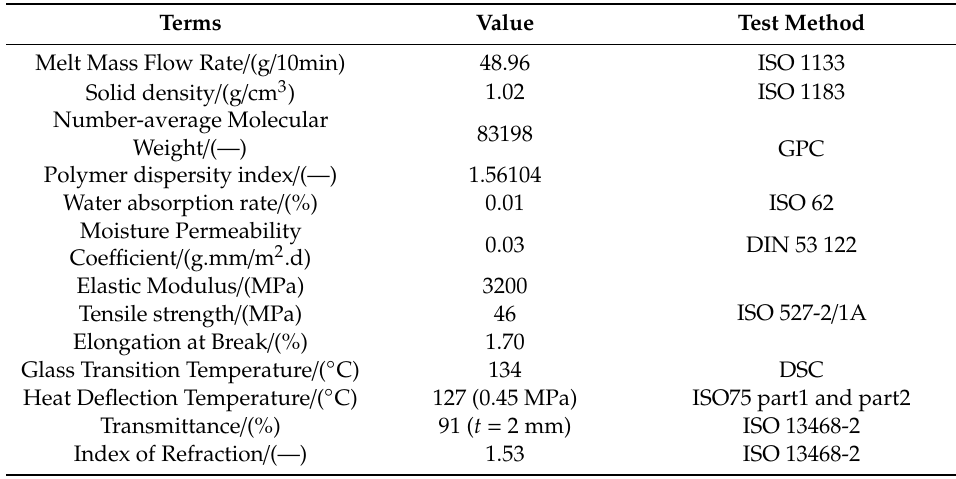
Table 1. Properties of TOPAS ® 5013-10L